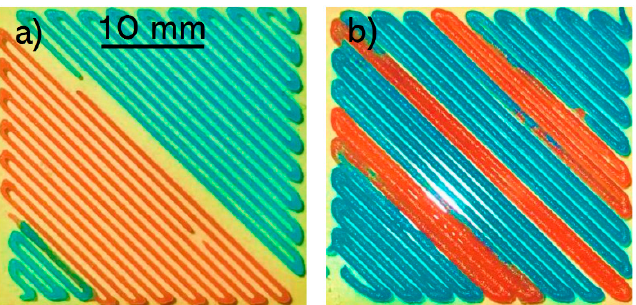
Figure 3. Comparison of a 30 mm × 30 mm square printed by ( a ) the commercially available multi-head bioprinter and ( b ) the developed SNMM printhead.